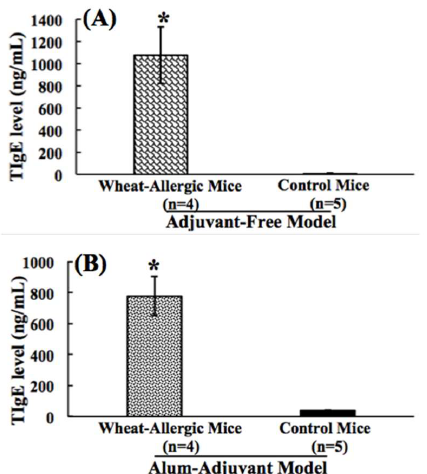
Figure 2. ( A – B ). Comparison of wheat protein-elicited plasma total IgE antibody responses in